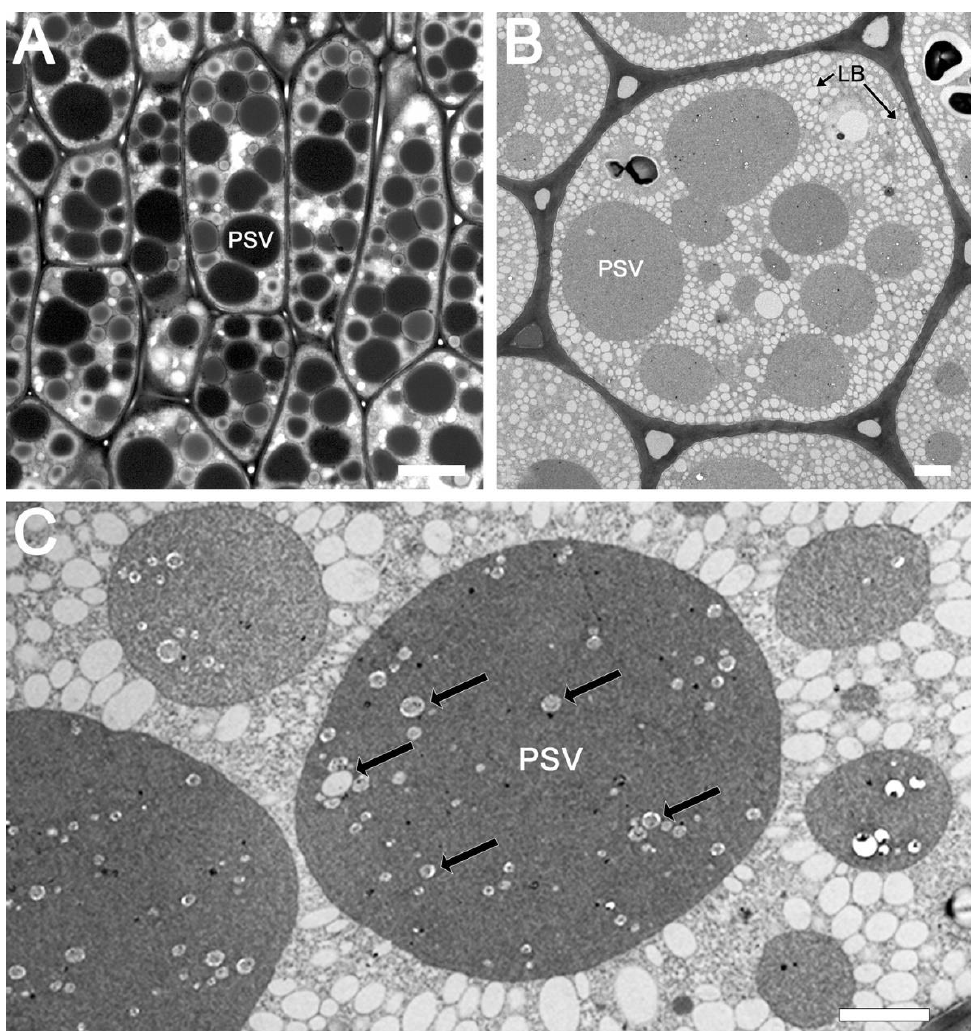
Figure 1. Visualization of protein storage bodies in the soybean seed cotyledon embedded in Spurr ’ s low-viscosity media using different microscopy techniques. Transmitted light image of toluidine blue-stained semi-thin section with 20 µm scale bar ( A ), and transmission electron microscopy images of soybean seed tissue dehydrated with acetone ( B ) or ethanol ( C ), with 2 µm scale bar. PSV = protein storage vacuole, LB = lipid body. Black arrows on image C point to phytate crystals.